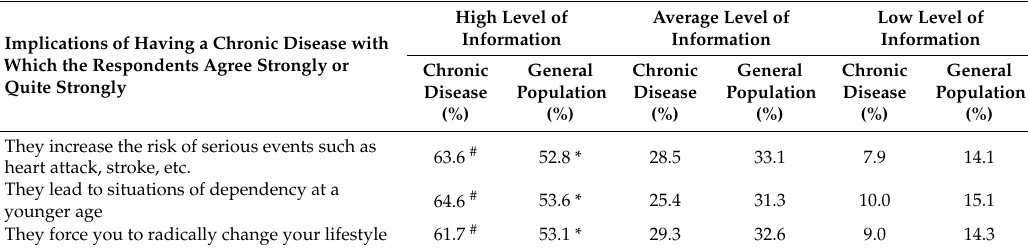
Table 3. Self-declared level of information of the respondents who agreed strongly or quite strongly with the following implications of having a chronic